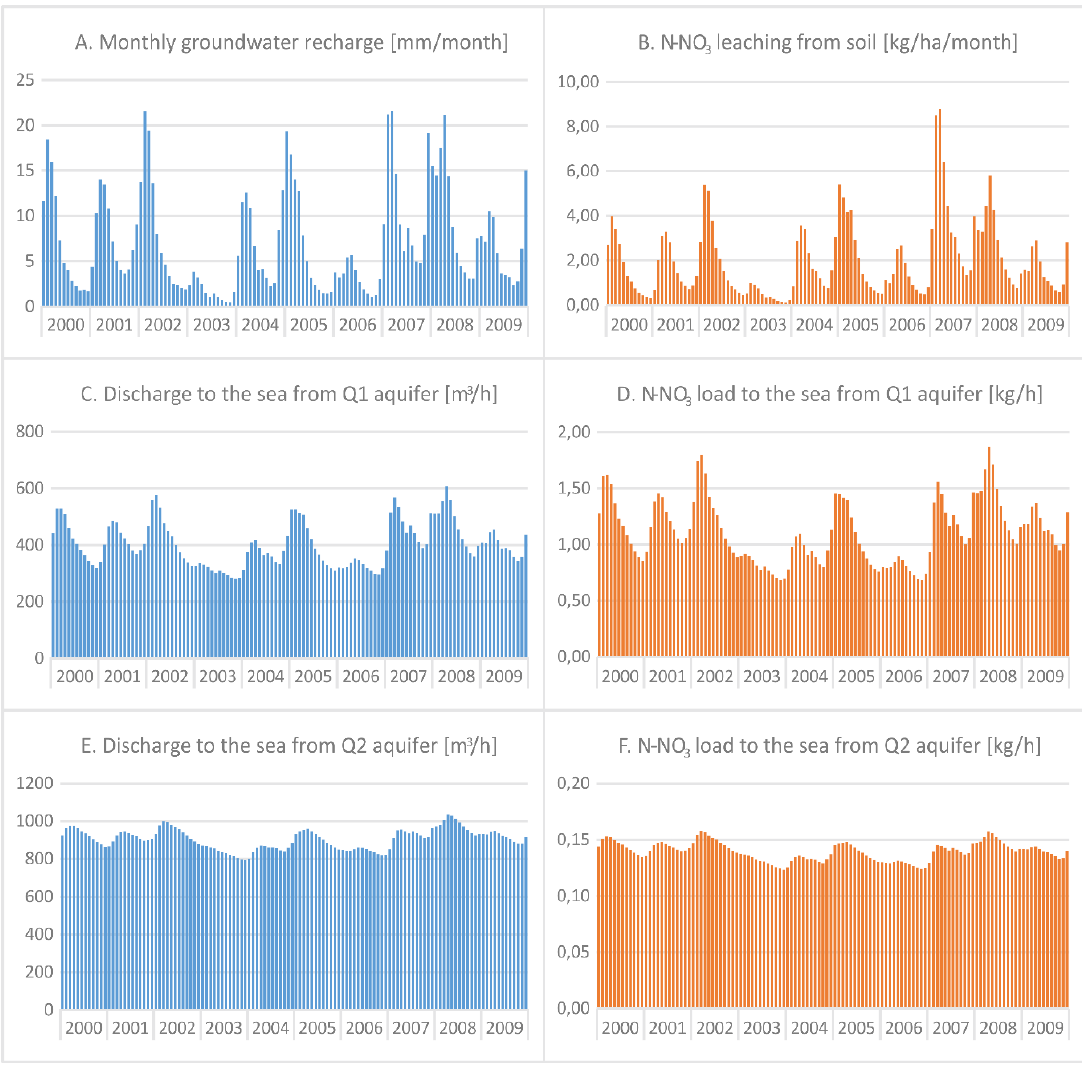
Figure 6. Average monthly values of selected groundwater budget components and N-NO 3 loads for scenario S3 (silage corn).